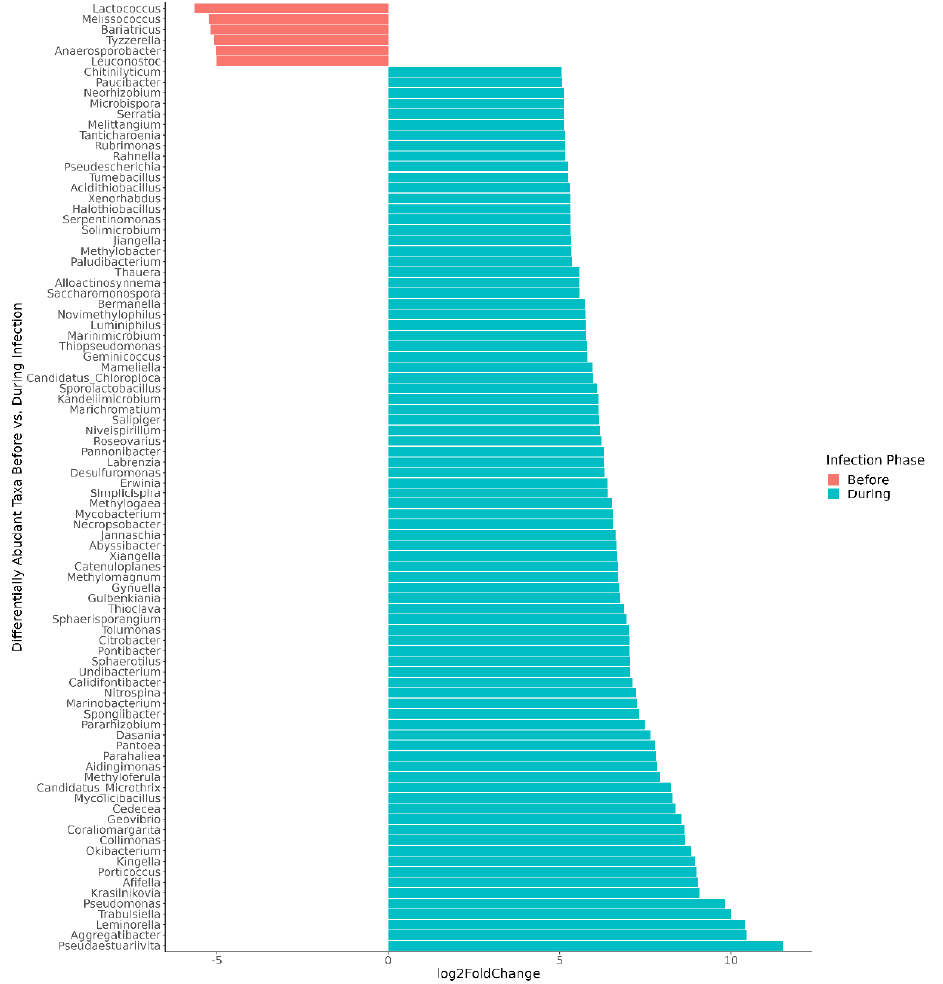
Figure 4. Differentially abundant genera, comparing microbiomes before versus during norovirus- associated AGE. Taxa demonstrating a >5 log2-fold change and adjusted p -values < 0.01 are shown in the figure. In all, 316 differentially abundant genera were found at the p -adj < 0.05 level. Participant A was excluded from the genus-level differential abundance analysis since the gut microbiome was not disrupted during